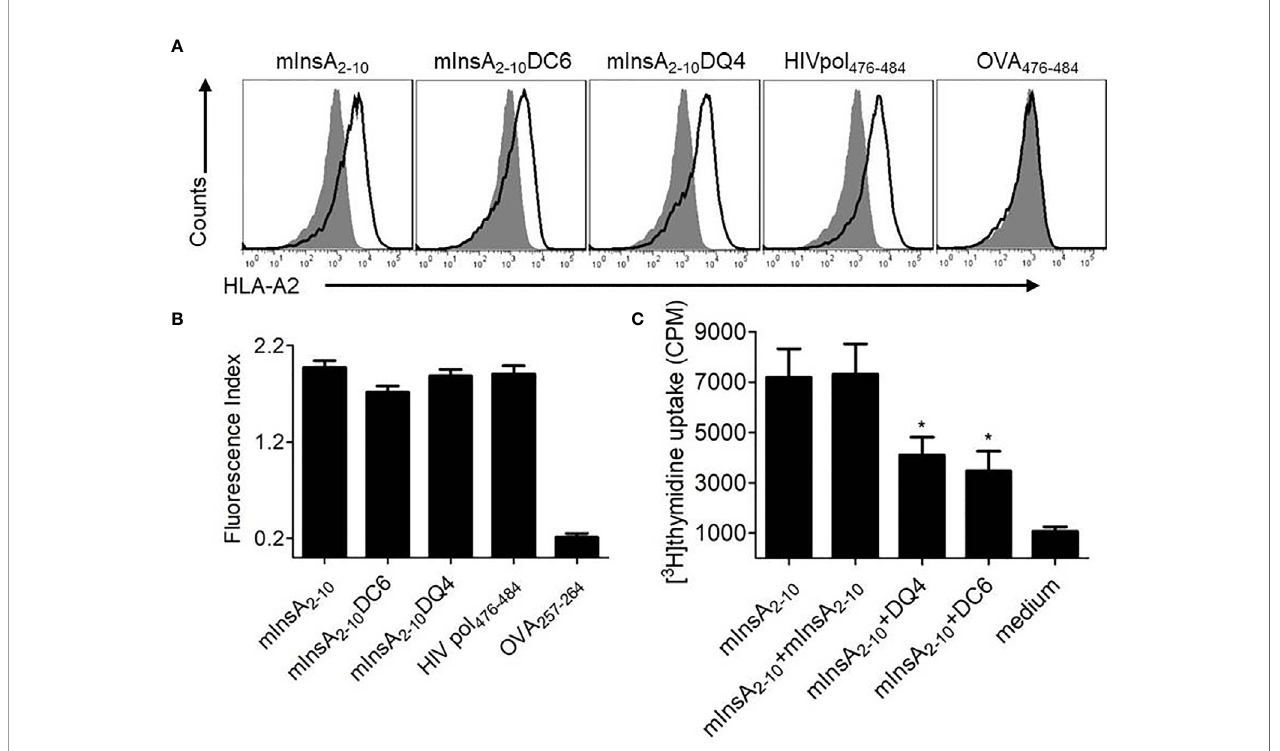
FIGURE 3 | Selection of a promising antagonist peptide for mInsA 2-10 . (A) T2 cells were incubated with or without the indicated peptides (50 m g/ml), and the stabilization of surface HLA-A2 molecules was detected by fl ow cytometry. The HLA-A*0201-binding peptide HIV Pol 476-484 was used as a positive control. The H-2K b -binding peptide OVA 257-264 was used as a negative control. Filled histograms, no peptide; open histograms, plus peptide. (B) The binding af fi nity was presented as the fl uorescent index (FI) that was calculated as follows: FI = (mean fl uorescence intensity with the given peptide − mean fl uorescence intensity without peptide)/(mean fl uorescence intensity without peptide). Bars represent the mean ± SEM of three independent experiments. (C) Splenocytes were treated with 10 m g/ ml mInsA 2-10 plus 10 m g/ml indicated peptides for 72 h in 96-well plates (2×10 5 per well) at 37°C. The cell proliferation was measured by [ 3 H] thymidine incorporation. Bars represent the mean ± SEM of seven independent experiments. *P < 0.05.